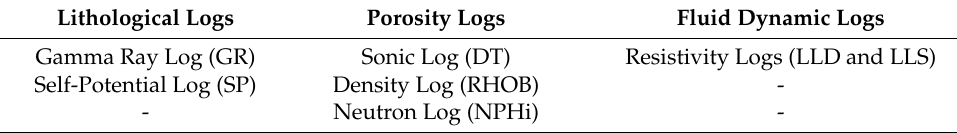
Table 5. Logs available for petrophysical interpretation of reservoir zones.